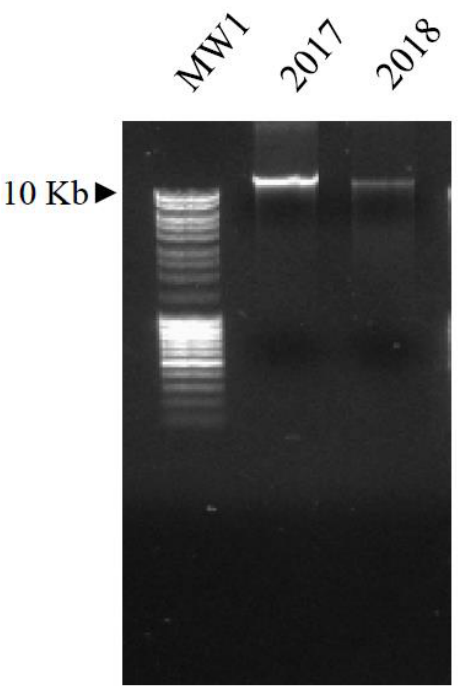
Figure 4. Visualization of the total DNA extracted from the two sets of samples (2017 and 2018), after separation on 1% agarose gel and exposure to UV light. MW1: molecular weight 1, as reported in the Materials and Methods section.